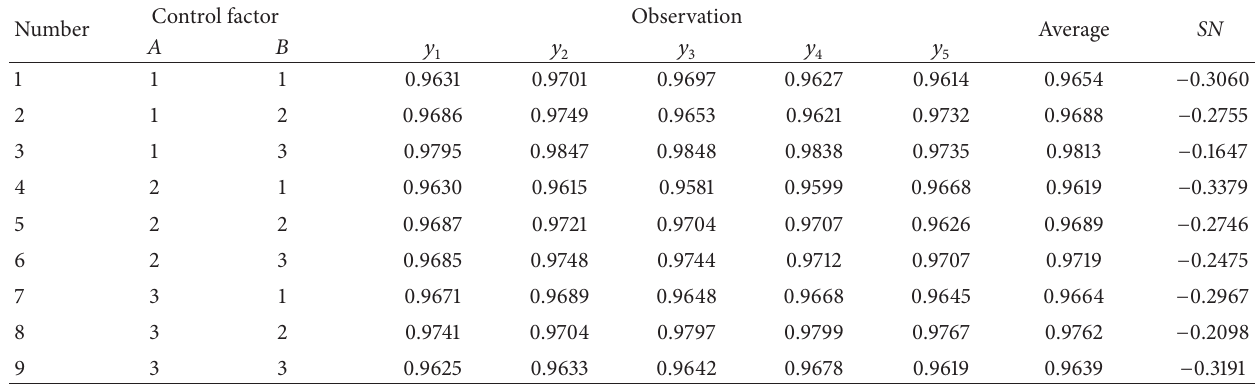
Table 6: Summary of experiment data of Dermatology database.